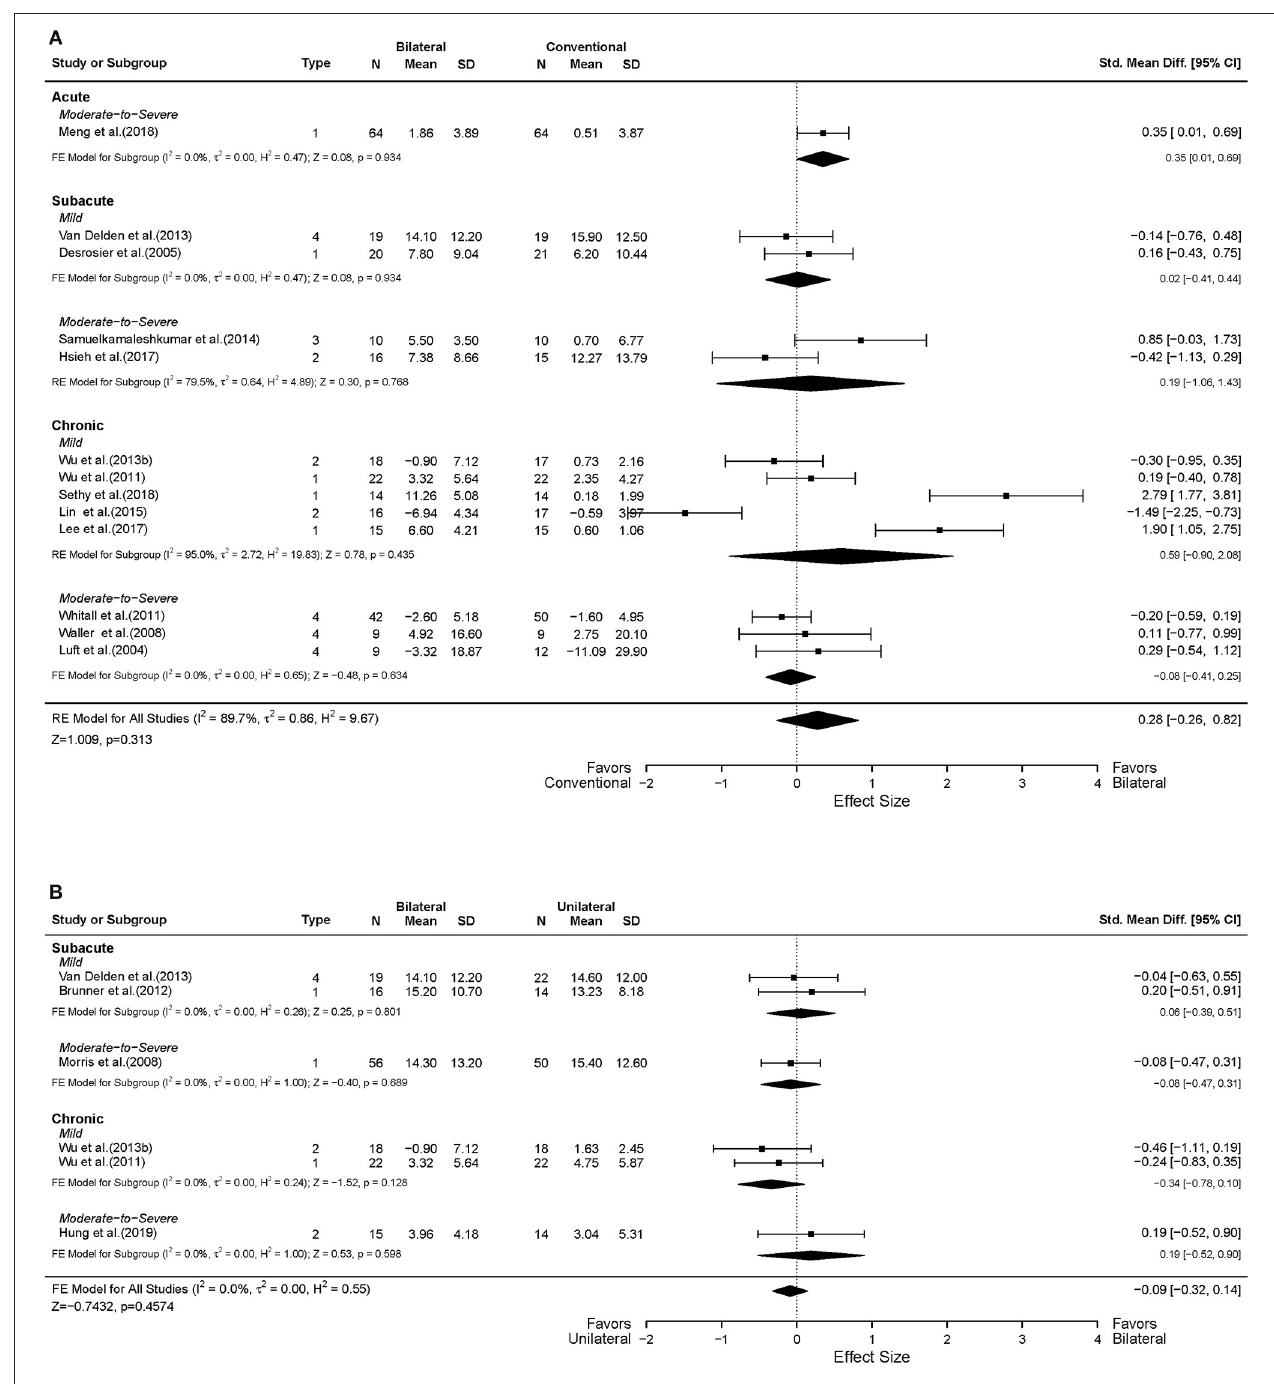
FIGURE 5 | Forest plots comparing the effects of (A) BAT vs. CT and (B) BAT vs. UAT on the upper extremity functional performance. 1 = bilateral functional training Test (BFTT); 2 = bilateral robot-assisted training (BRAT); 3 = bilateral arm training with rhythmic auditory cueing (BATRAC); 4 = mirror therapy (MT); BAT, bilateral arm training; CI, confidence interval; CT, conventional therapy; FE, fixed-effects; RE, random-effects; Std. Mean Diff., standardized mean difference; UAT, unilateral arm